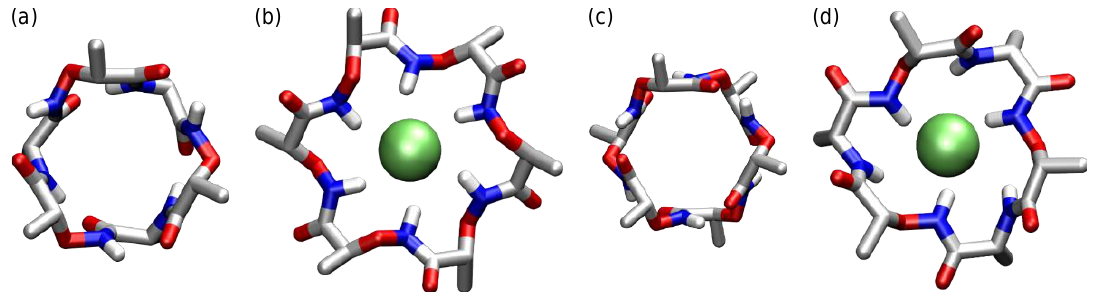
Figure 3. Calculated structures of uncomplexed 3 ( a ) and its chloride complex ( b ), and of uncom- plexed 4 ( c ) and its chloride complex ( d ). The calculations were performed by the author of this review based on the reported results by using Spartan 20 (Wavefunction, Inc., Irvine, CA, USA) and the MMFF force-field (see Supporting Information). The side chains of both cyclic pseudopeptides are truncated and protons, except acidic ones, are omitted for reasons of clarity.